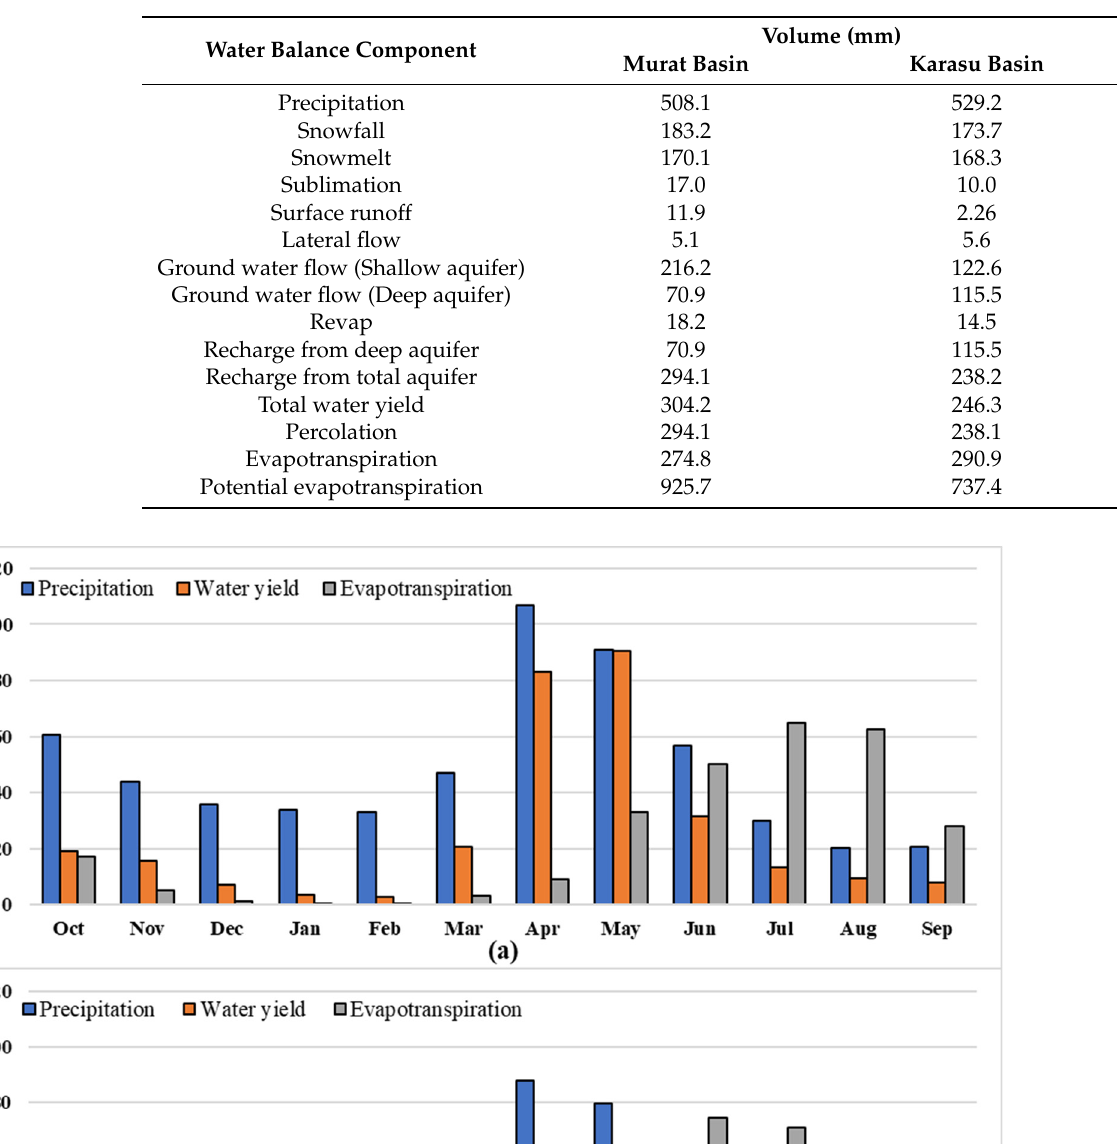
Table 9. Annual water balance components of SWAT.